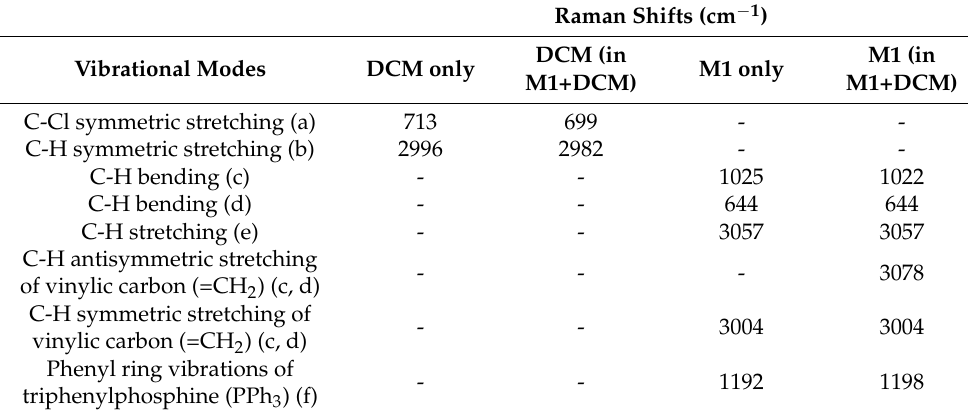
Table 1. Various vibrational modes for M1 and DCM treated M1. Raman Shifts (cm − 1 ) M1 (in DCM (in M1 only Vibrational Modes DCM only M1+DCM) M1+DCM) C-Cl symmetric stretching (a) 713 699 - - C-H symmetric stretching (b) 2996 2982 - - C-H bending (c) - - 1025 1022 C-H bending (d) - - 644 644 C-H stretching (e) - - 3057 3057 C-H antisymmetric stretching - - - 3078 of vinylic carbon (=CH 2 ) (c, d) C-H symmetric stretching of - - 3004 3004 vinylic carbon (=CH 2 ) (c, d) Phenyl ring vibrations of - - 1192 triphenylphosphine (PPh 3 ) (f)